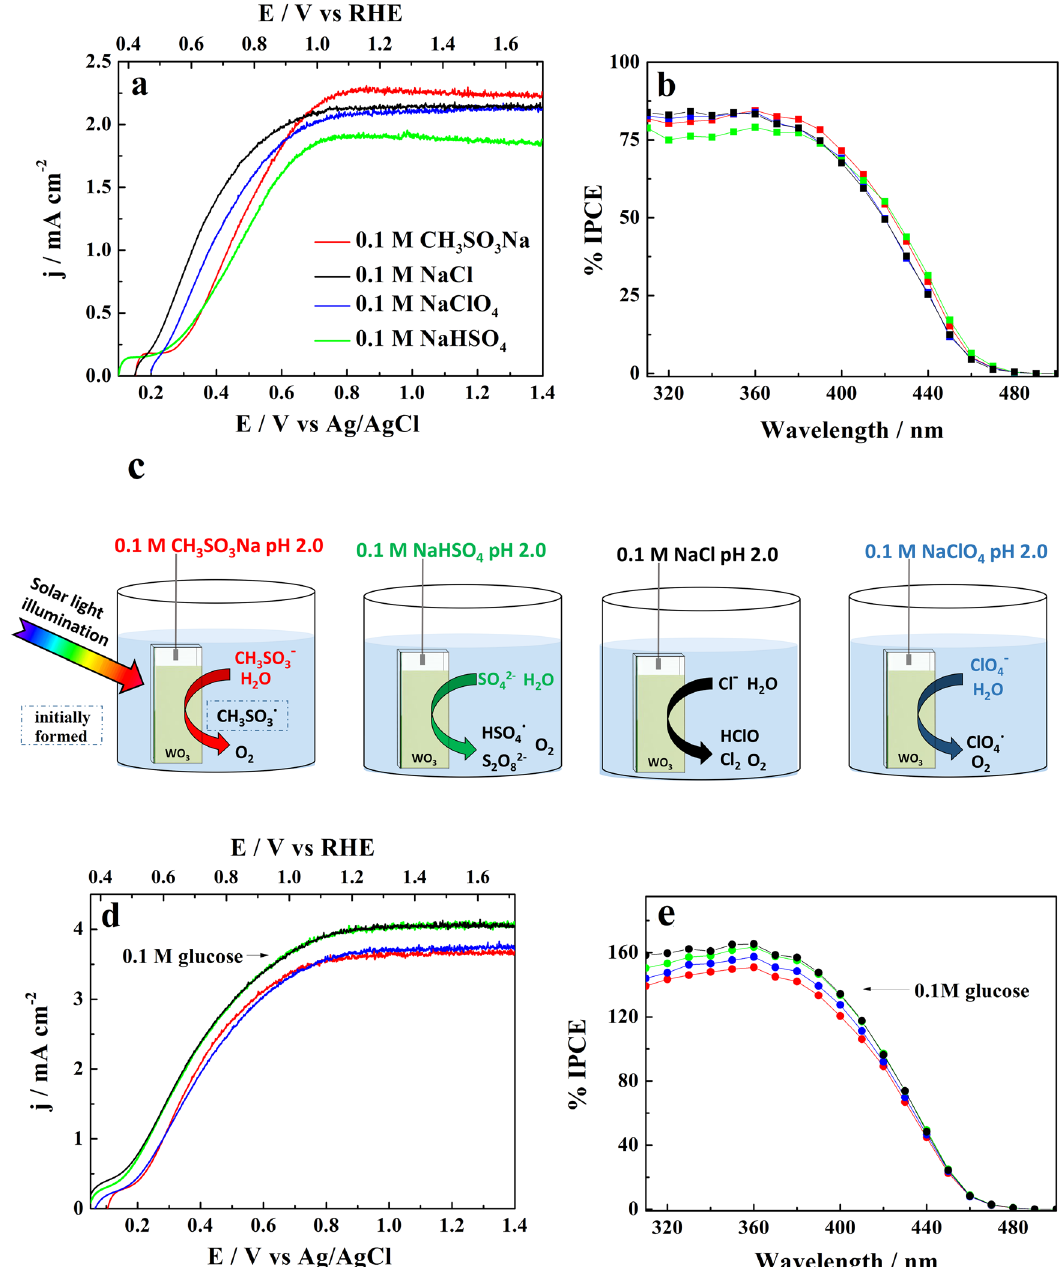
Fig. 2 Photoelectrochemical glucose oxidation performance. a Photocurrent densities vs imposed potential (j-E) plots recorded under simulated AM 1.5 G irradiation and b , The corresponding incident photon-to-current ef fi ciency (IPCE) spectra measured at 1.23 V vs RHE for a ~1.2 μ m thick fi lm WO 3 electrode in a series of 0.1 M supporting electrolytes acidi fi ed to pH 2. c The photo-oxidized species formed on the WO 3 photoanode in the employed electrolytes. d Effect of the addition of 0.1 mol L − 1 of glucose upon j-E plots recorded for the electrolytes listed in ( a ). e , The corresponding IPCE